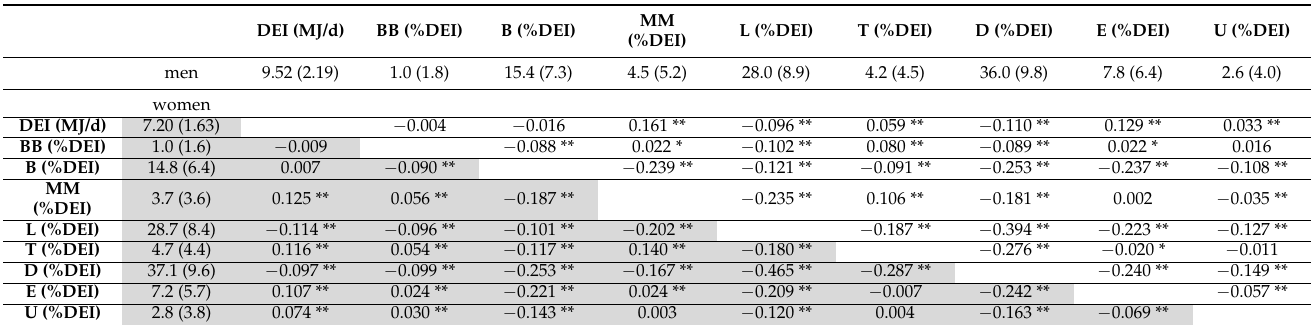
Table A1. Correlations between DEI and the Percentages of DEI Consumed at the Eight Recording Sections in the Pre-Structured 7dDD.